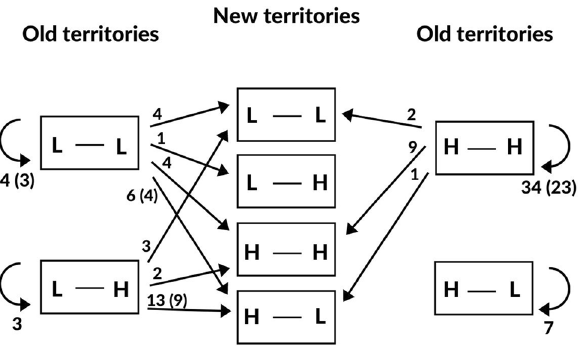
Figure 1. Between-year settlement decisions of red-necked grebes nesting on fish ponds of contrasting habitat quality. Combinations of letters within boxes indicate changes or consistency in habitat quality from year t to year t + 1, L—low-quality habitat, H—high-quality habitat. Old territories are ponds occupied in year t, new territories are ponds where birds shifted in year t + 1. Arrows indicate directions of between-year movements. Returning arrows represent pond fidelity between years. Numbers refer to sample sizes; numbers in parentheses were added when the same individuals were sampled more than